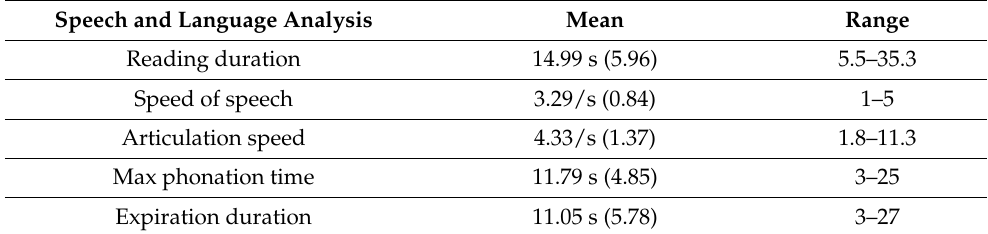
Table 5. Speech and language analysis.